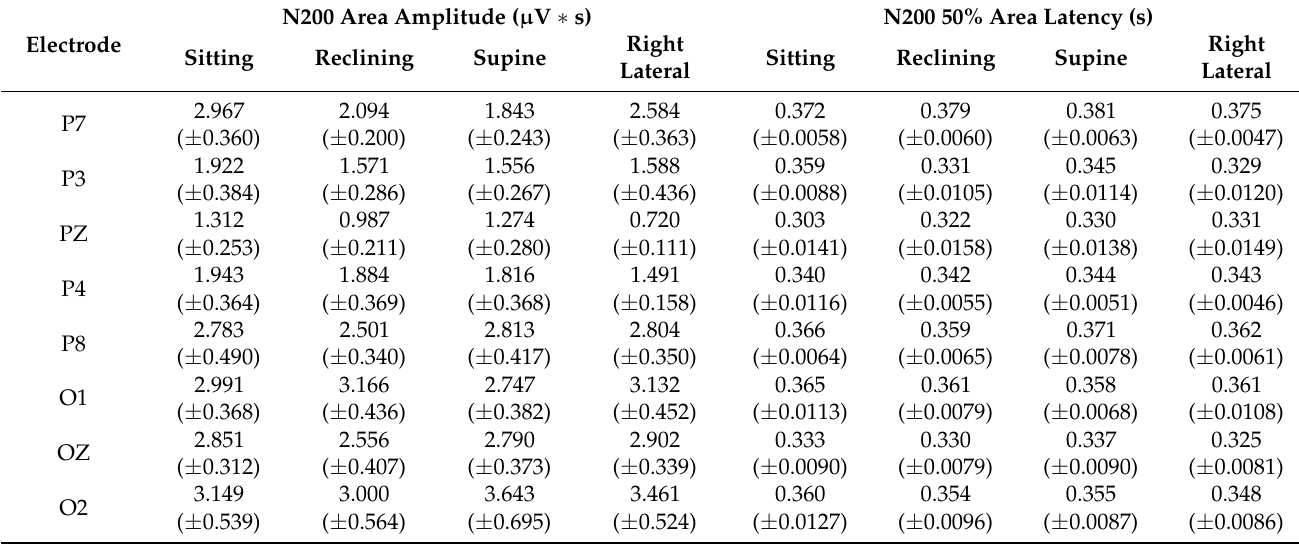
Table A2. Area amplitude ( µ V ∗ s) and 50% area latency (s) for the N200 in each posture (mean ± standard error).